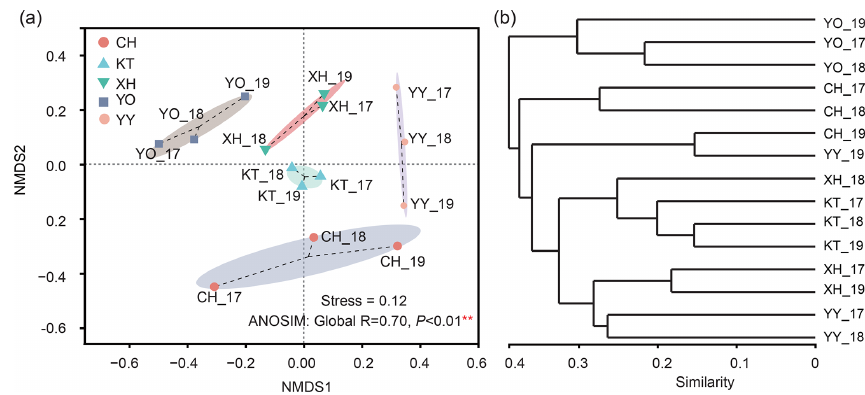
Figure 4. Temporal variability analysis of non-metric multidimensional scaling (NMDS) ordination of the microbial eukaryotic communi- ties (a) and clustering of five lakes based on similarity (b) .